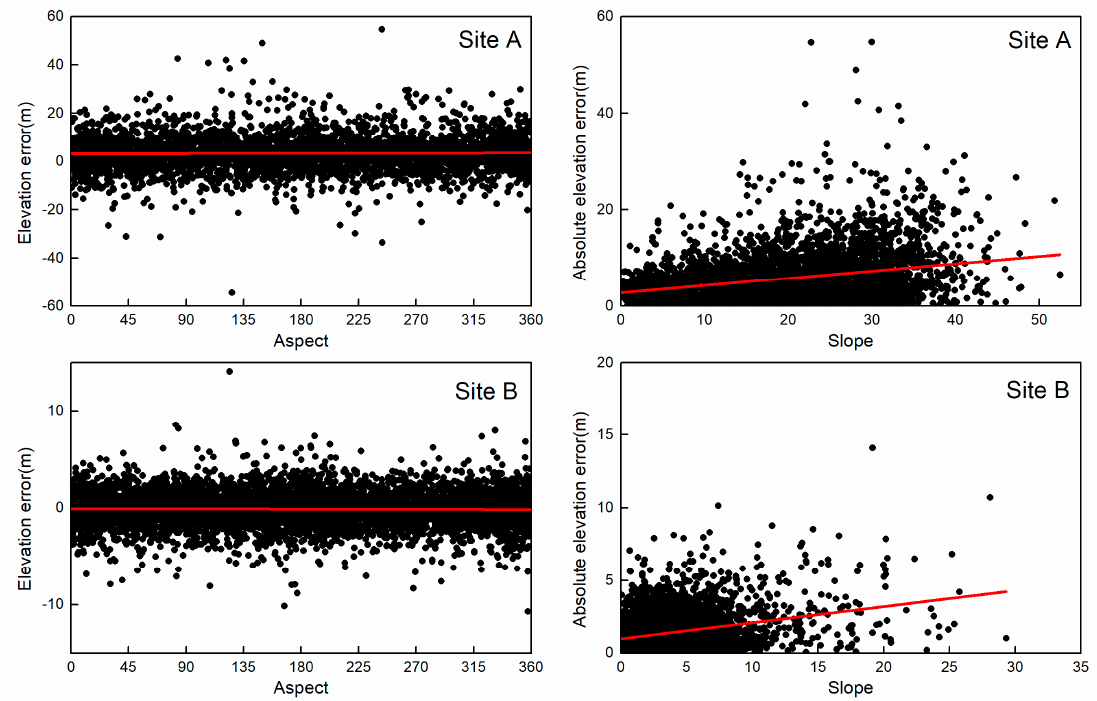
Figure 10. Relationship between the DEM N elevation error and slope and aspect.